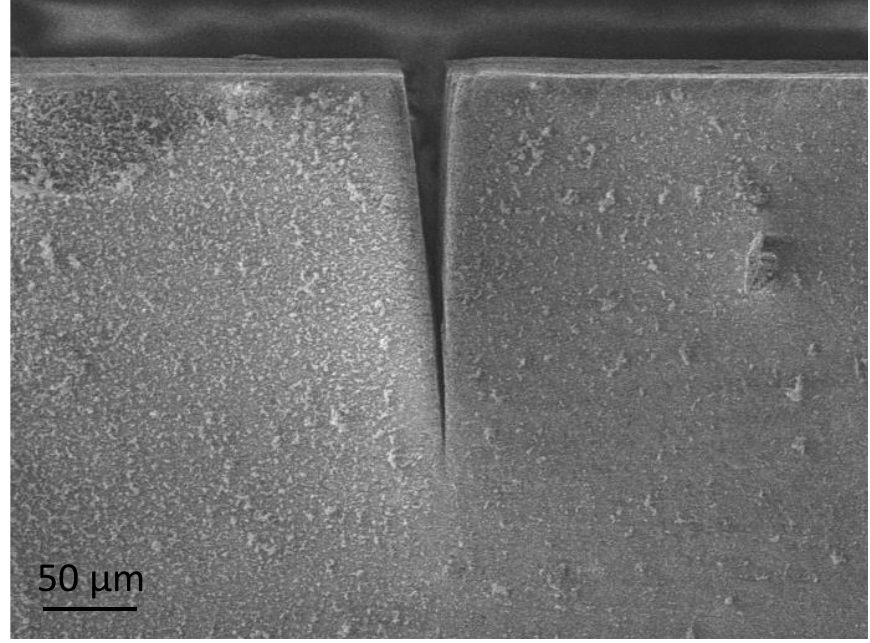
Figure 2. Field emission scanning electron microscopy (FESEM) image of the single edge laser-notch beam (SELNB) sample of LU.